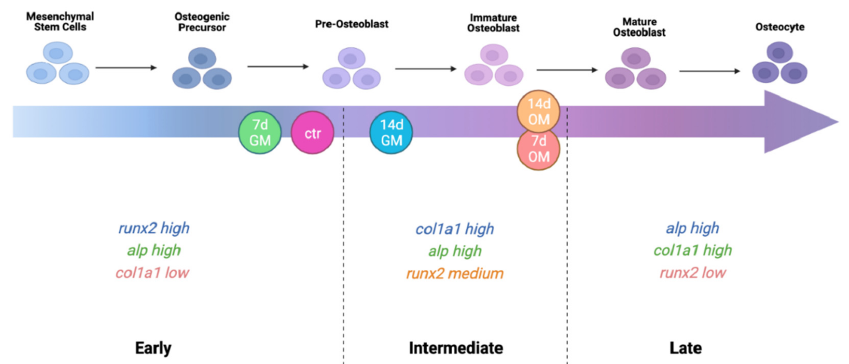
Figure 8. Schematic figure that represents our proposal of the dynamic gene expression patterns occurring during phase 3 of bone formation. This image has been conceptualized based on the current literature knowledge and our experimental data. Moreover, the differentiation patterns reported here refer to the differentiation of hASCs, thus they might be different for other stem cell